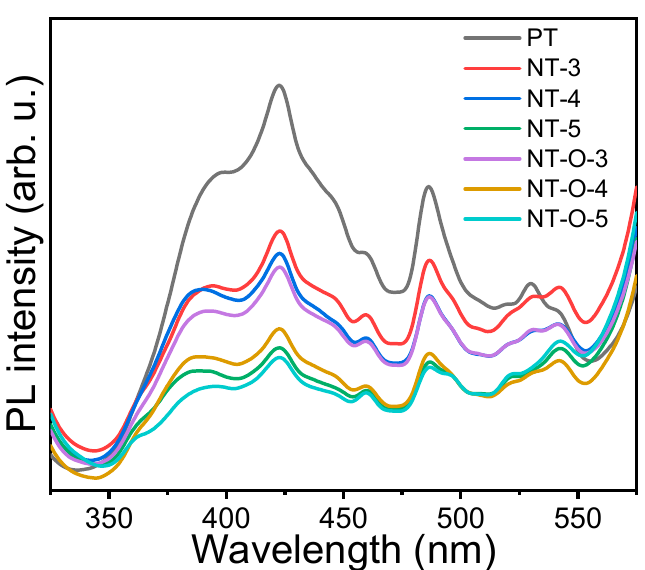
Figure 5. PL spectra of solid TiO 2 samples.